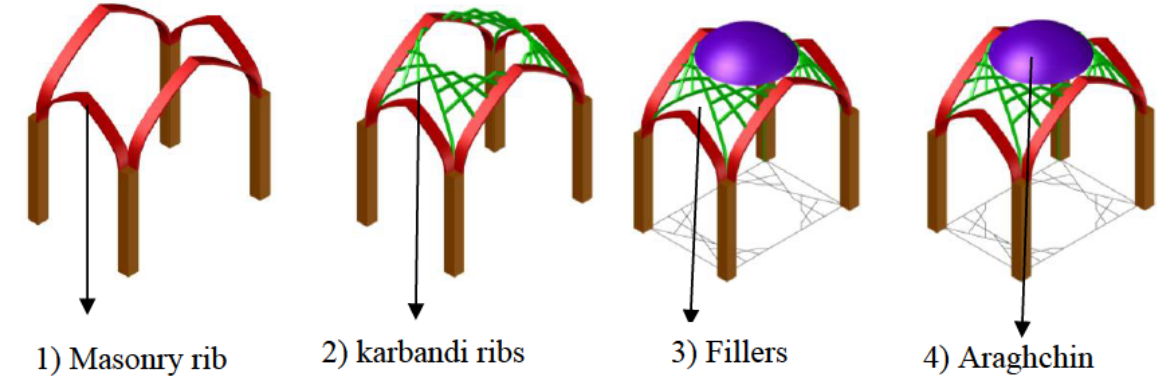
Figure 2: Karbandi